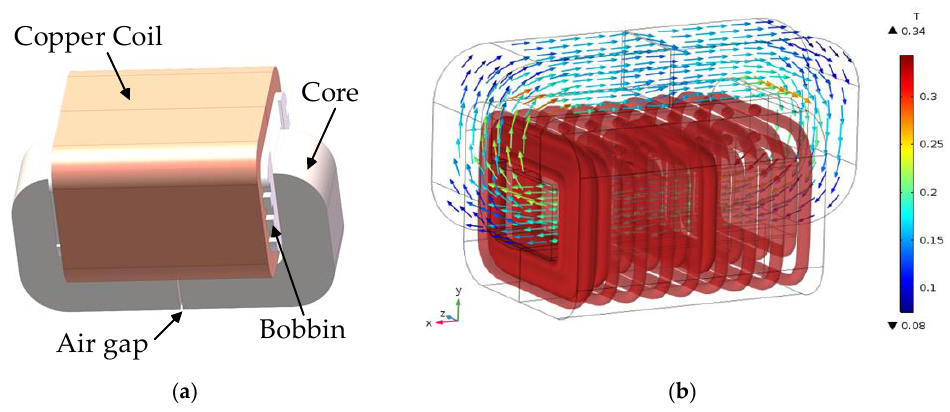
Figure 8. ( a ) SOLIDWORKS inductor design, ( b ) Magnetic flux distribution and current distribution of inductor in the COMSOL Multiphysics (Version 5.3a, COMSOL, Inc., Burlington, MA, USA, 2018).